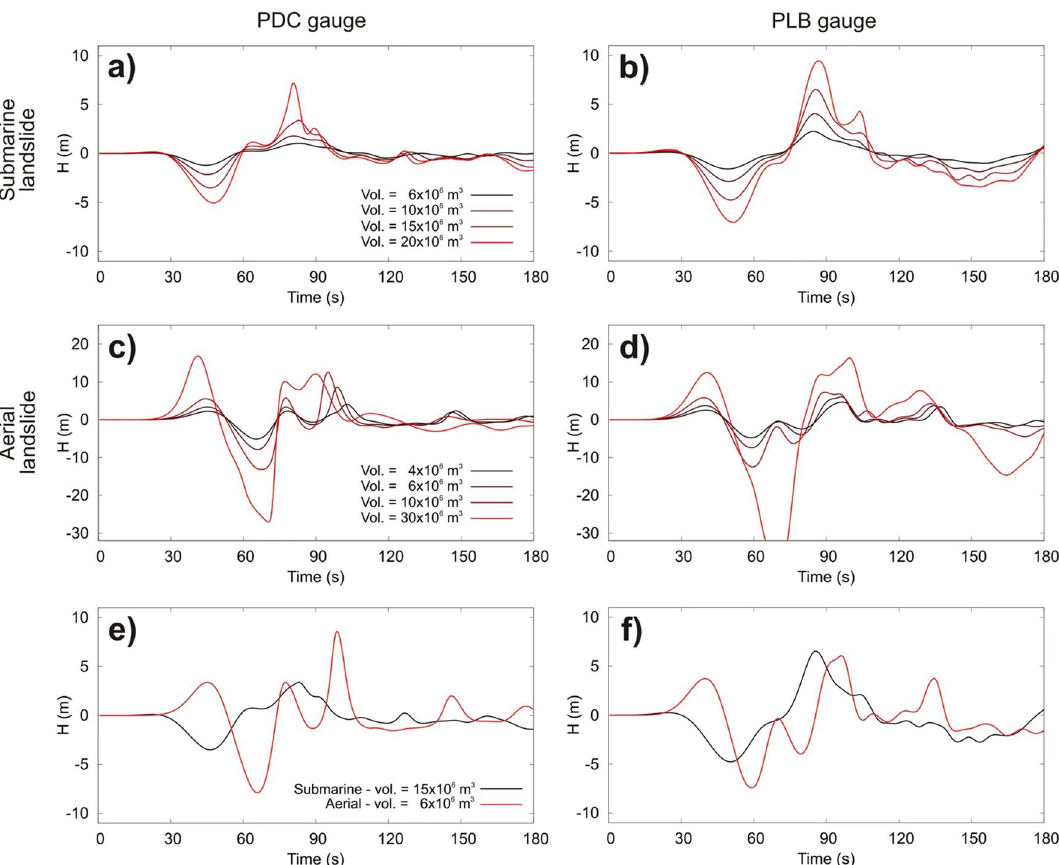
Figure 3. Wave shapes calculated at the monitoring gauges of PDC and PLB. Legends at PDC are also applies for PLB. Comparison between the waves generated by the aerial slide of 6 × 10 6 m 3 and the subaqueous slides of 15 × 10 6 m 3 are shown in frames ( e , f